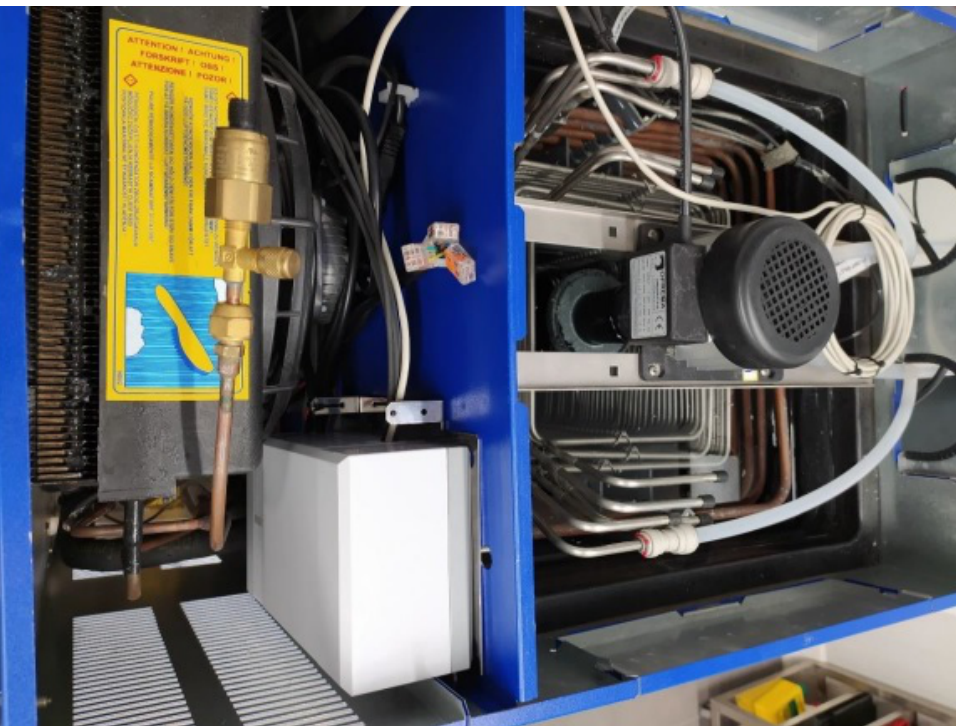
Figure 5. Beverage cooling device upgraded with smart option produced by Oprema